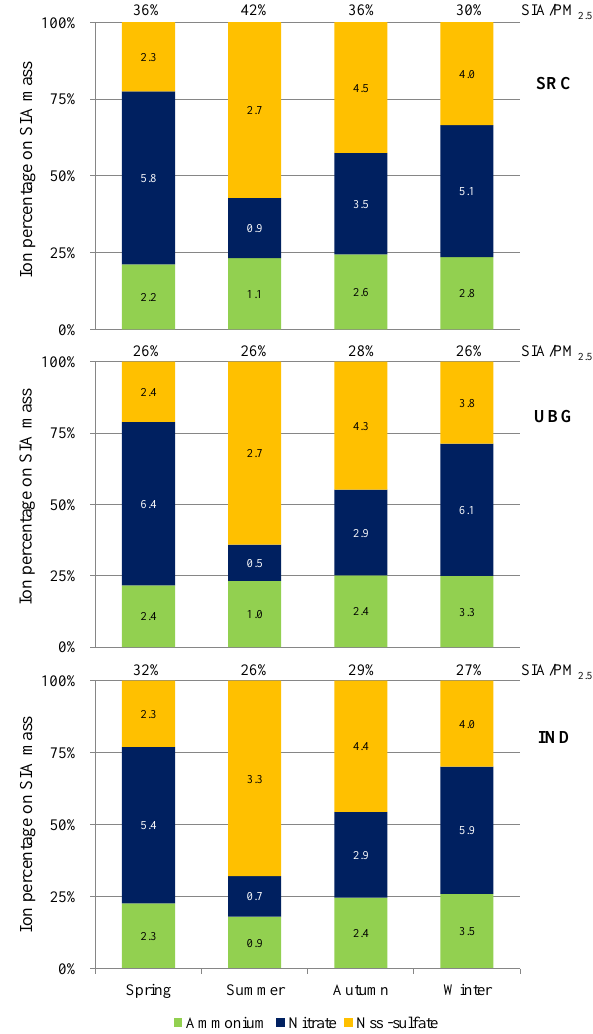
Fig. 2. Relative seasonal contribution of ammonium, nitrate and nss-sulfate on SIA at each sampling site. The percentage at the top of each bar represents the SIA contribution on PM 2 . 5 . The measure inside the bars represents the average concentration (µgm − 3